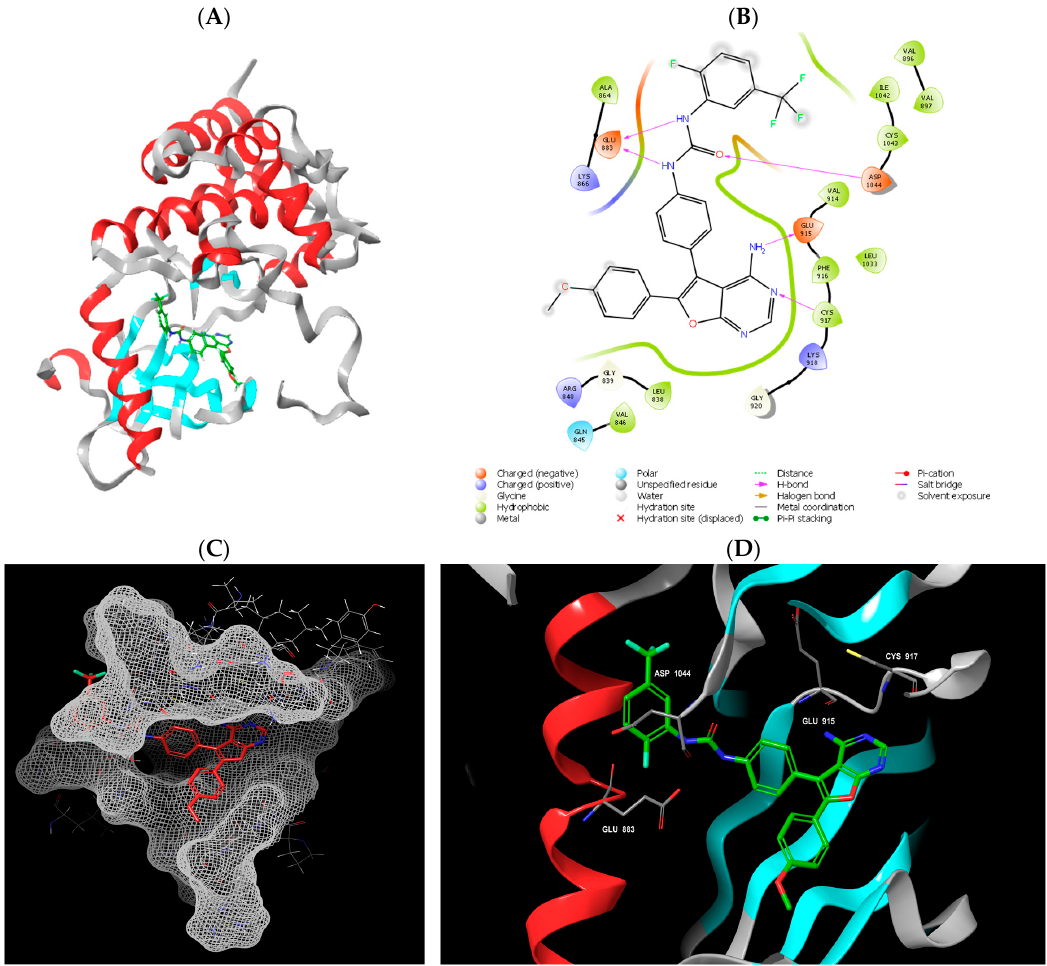
Figure 7. Docking of the original co-crystallized ligand (N-{4-[4-amino-6-(4-methoxyphenyl)furo[2,3-d]pyrimidin-5-yl]phenyl}-n’-[2-fluoro-5-(trifluoromethyl)phenyl]urea) with VEGFR2 (1YWN). ( A ) Ribbon representation showing ligand pose in chain A; ( B ) 2D interaction of ligand with binding pocket; ( C ) mesh representation of binding pocket surface interaction with ligand; ( D ) 3D interaction of ligand with binding pocket showing involved amino acids.